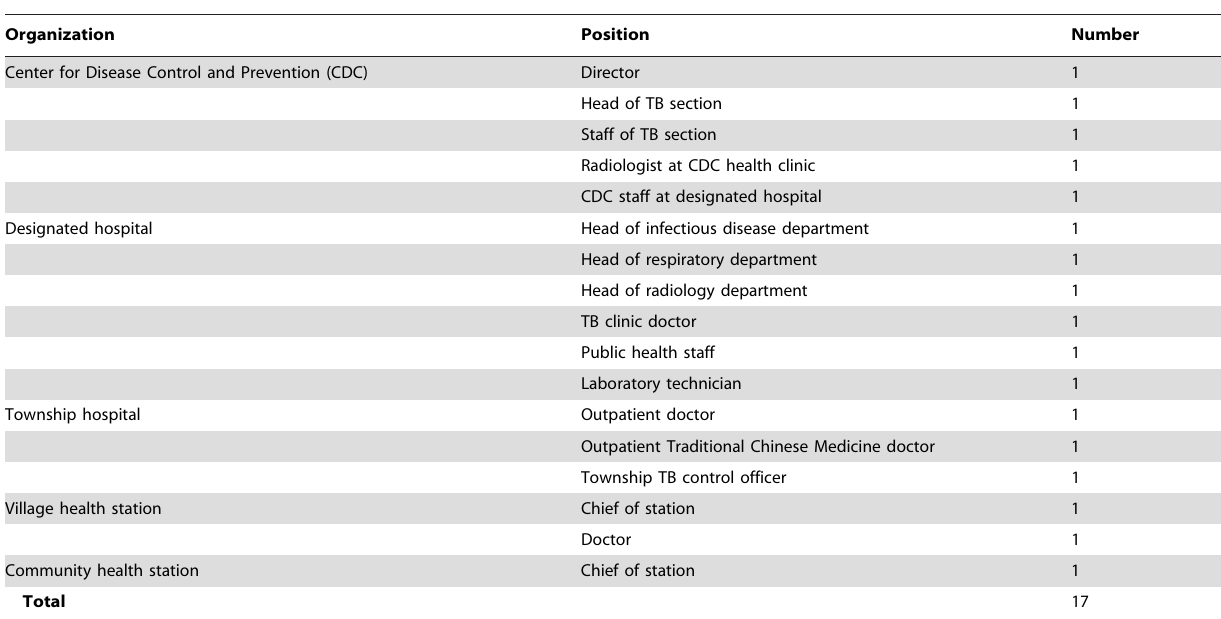
Table 1. Sampling for in-depth interviews in ZJG